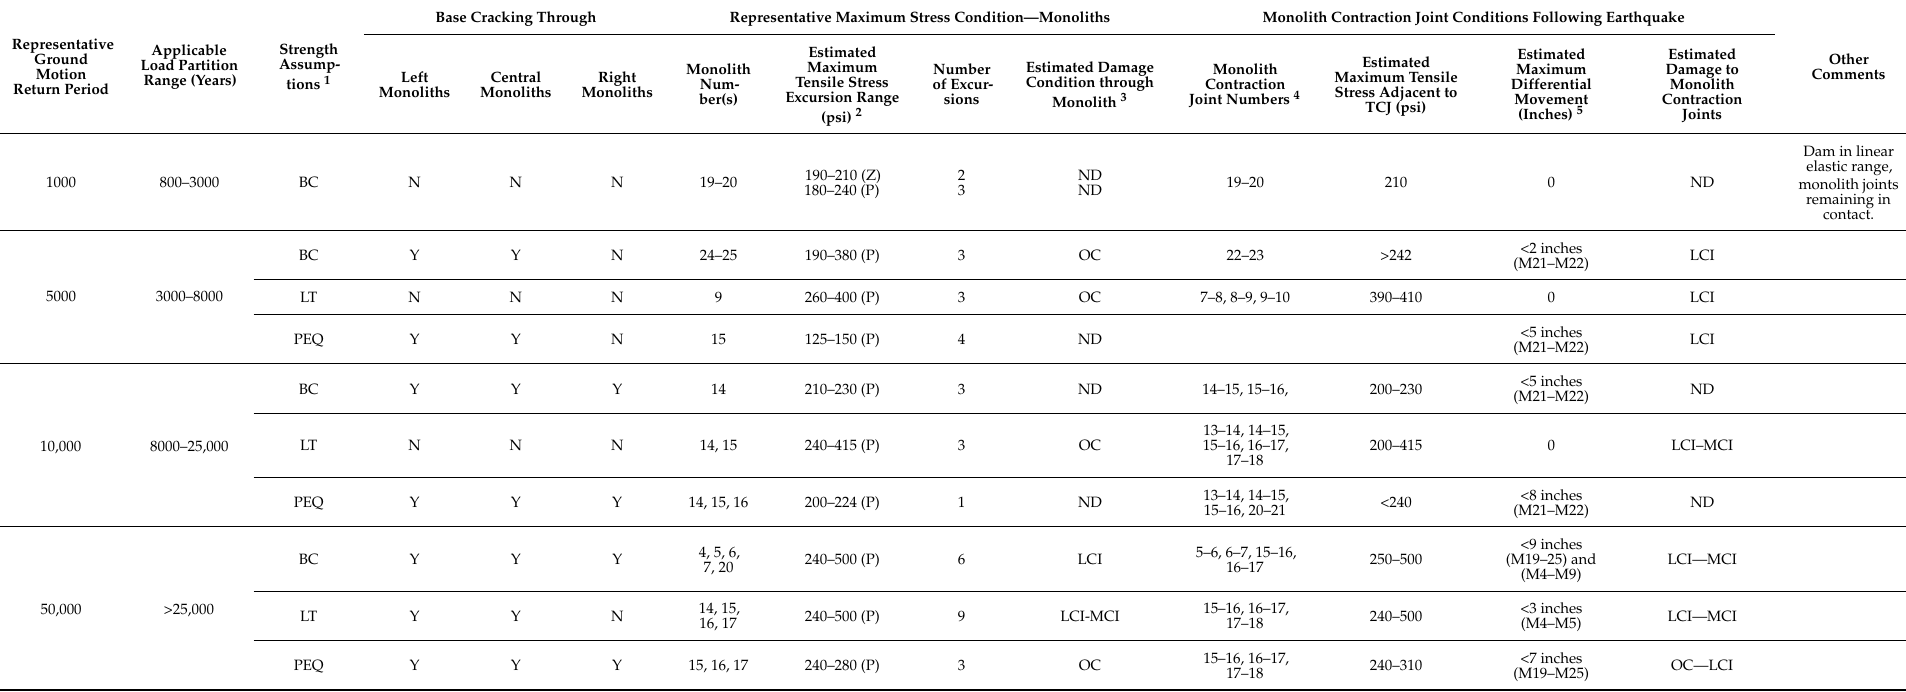
Table A5. Summary of study case results for risk analysis—monolith stresses and damage estimated from 3D model—MYG008 (short duration local/interslab ground motion). Column 2 shows the seismic load partition range used in the Risk Analysis for which the representative ground motion return period (shown in Column 1) was used to assess the performance of the